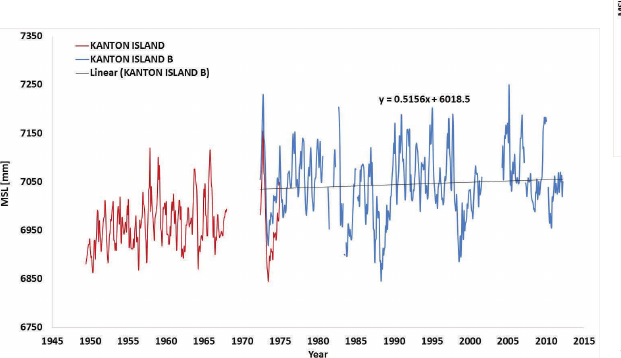
Fig.6isacomparisonofthemonthlyaveragemeansea levels measured in KANTON ISLAND-B and CHRISTMAS ISLAND II between 1992 and 2012. Apart from the missing data of KANTON ISLAND-B 2001 to 2004 filtering out one positive peak and so biasing the relative rate of rise up, the two tide gauge records have a remarkably similar trend.